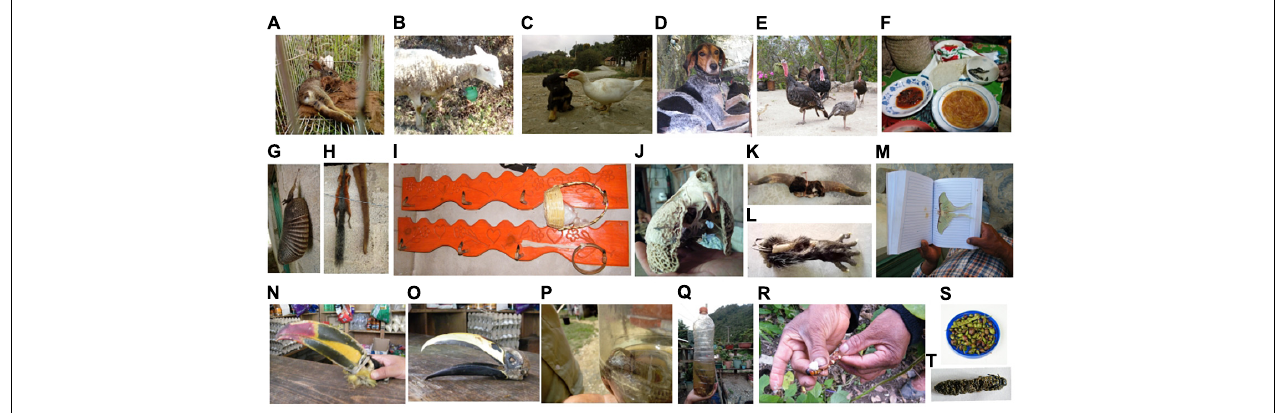
FIGURE 3 | Animals managed and used. (A) A captured rabbit ( Sylvilagus sp.) is held in captivity in Sierra; (B) lambs are forced to use a bottle in their mouth to prevent conflicts caused by grazing in inappropriate places; (C) a duck grooms a puppy in Sierra. These birds are kept in homes to prevent illness in other domestic animals; (D) Chaparra, a specialised hunter dog in TC; (E) Turkeys are considered to be rude, but highly appreciated as edible and gifts in celebrations; (F) A meal with Poxokuili ( Arsenura polyodonta Jordan) bought in the municipal head plaza prepared in “salsa” and a soup. These poxokuili are collected from Ceiba sp. tree in Chimalhuaca, a nearby village, and are annually available around August, depending on the rainfall. Men collect them and women prepare and sell them; (G) An armadillo carcase exhibited in TC, (H) Sciurus aureogaster skin exhibited in TC; (I) Furniture with Mazama temama legs as pieces; (J) C. paca skull kept in exhibition in a home in TC after being eaten; (K) bull horns exhibited in a home in Sierra, (L) Didelphis sp. hand kept as a souvenir in Sierra; (M) Actias truncatipenis (Sonthonnax, 1899) and other butterflies are kept as a souvenir in the Sierra; Some yellow butterflies are used by children as temporal tattoos; Toucan’s bills are exhibited and used in traditional medicine in TC (N,O) ; (P) Snakes that are perceived as poisonous are drowned and kept in sugarcane alcohol as part of the first-aid kit in homes in Sierra and TC; (Q) The dorsal gland of a peccary is kept in sugarcane alcohol to attend labour complications in TC; (R) While the outer part of immature Hepialidae are edible, the inside is used to treat herpes labialis; (S) Vespidae- Leucaena sp. galls are sold in municipal seat plaza as a snack. (T) Arsenura polyodonta are individually prepared with the quelite known as “ pipitza ” [ Porophyllum tagetoides De Candolle